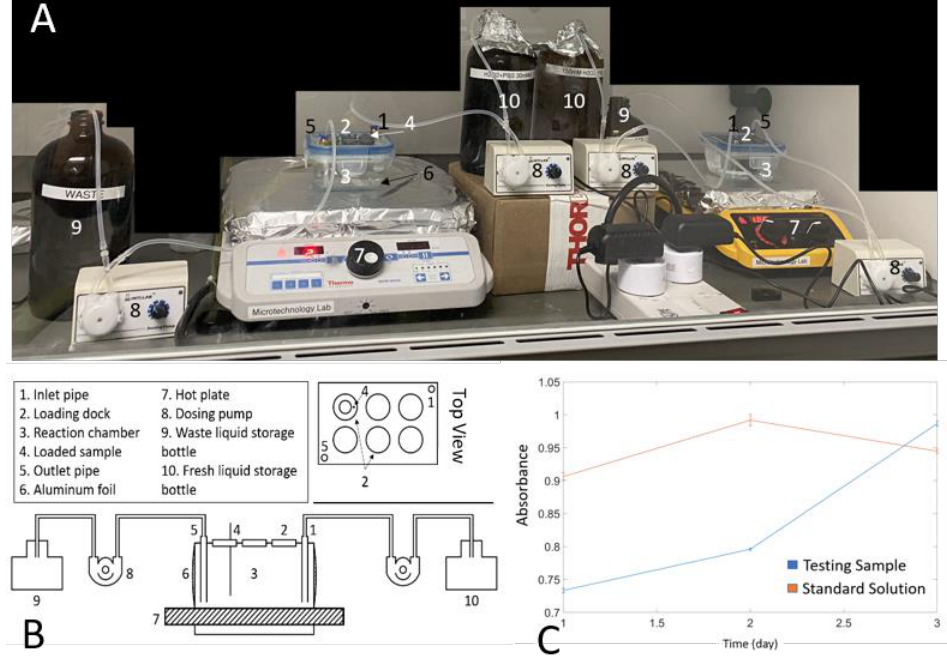
Figure 2. ( A ) RAA test platform, ( B ) Schematic diagram of the flow cell, ( C ) UV-visible spectroscopy of 30 mM H 2 O 2 + PBS testing solution comparing with standard solution (freshly prepared H 2 O 2 + PBS (30 mM) solution).